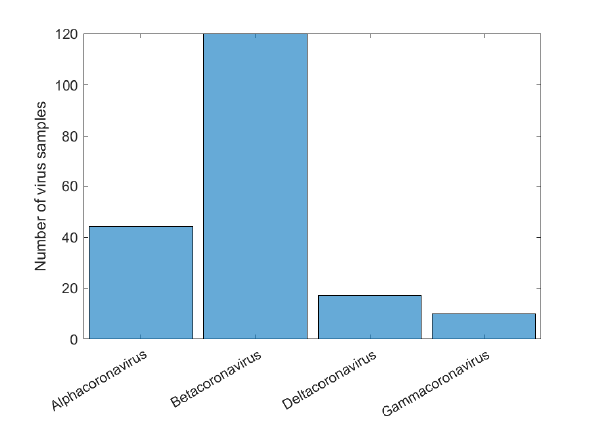
Figure 8. Histogram of sample distribution for the Exp3 before